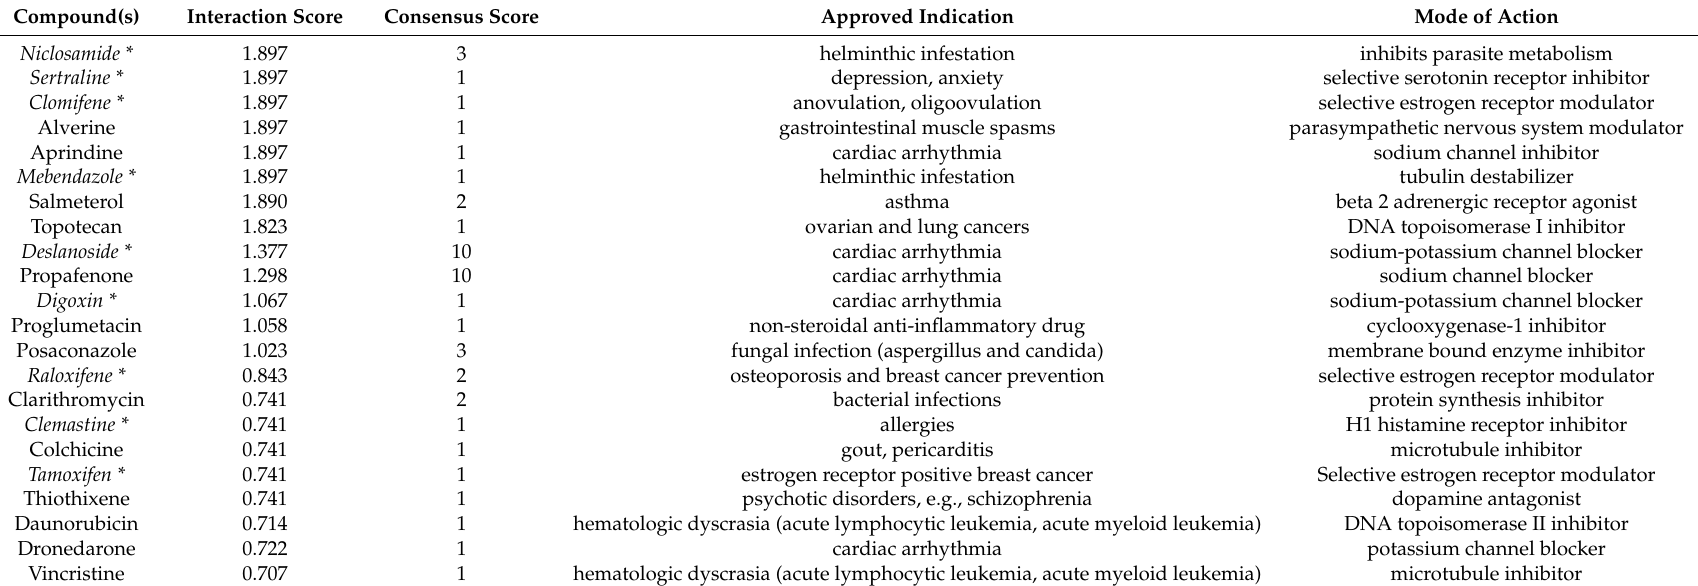
Table 2. Overlap between drug candidates identified by the CANDO platform and those identified by Kouznetsova et al. [27].